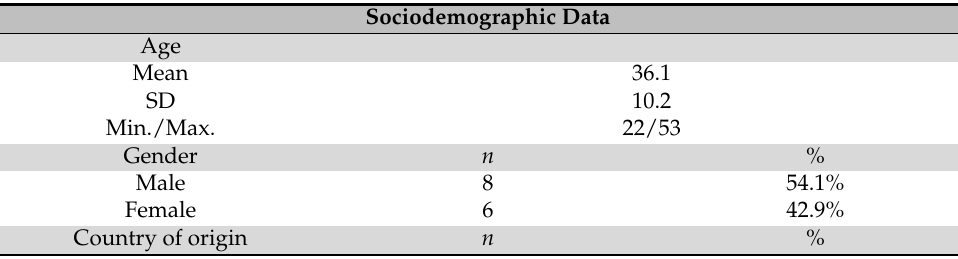
Table 1. Sociodemographic data of the